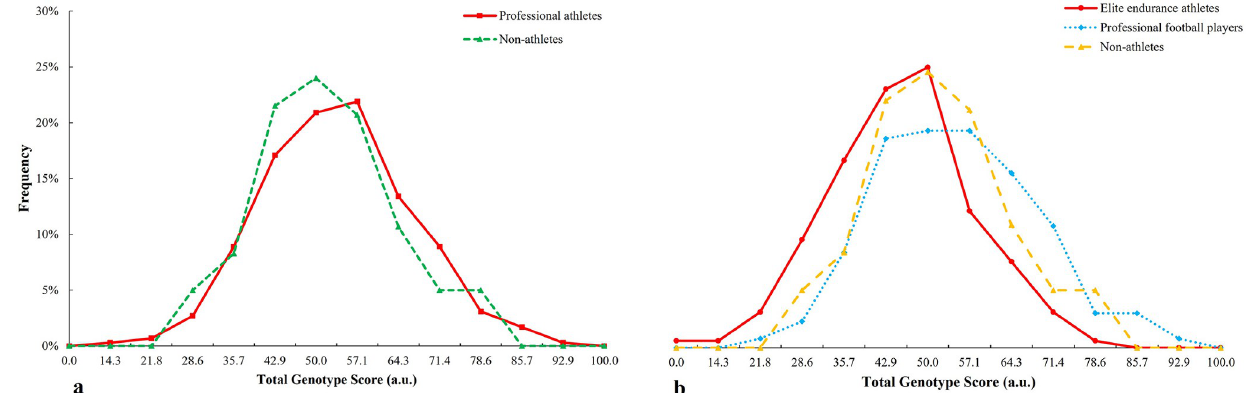
Fig 5. TGS distribution of cardiorespiratory fitness in a) professional athletes and non-athlete subjects and b) endurance athletes and football players with regard to non-athlete subjects.